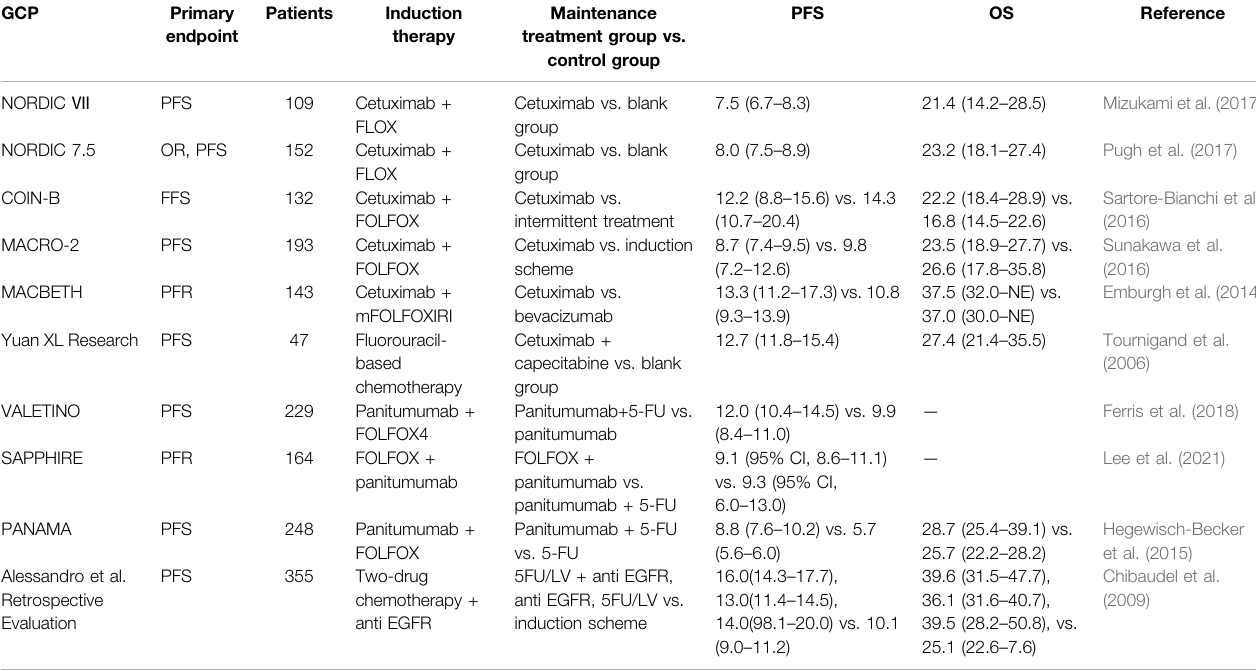
TABLE 1 | Summary of studies about the maintenance therapy of anti-EGFR mAb in Ras wild-type mCRC.